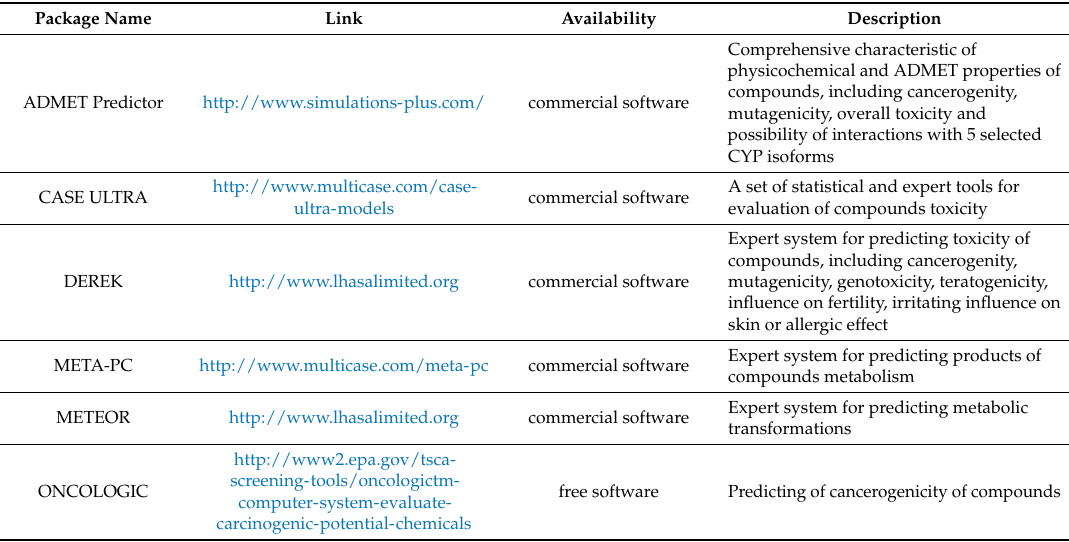
Table 1. A summary of some of the available tools for ADMET properties